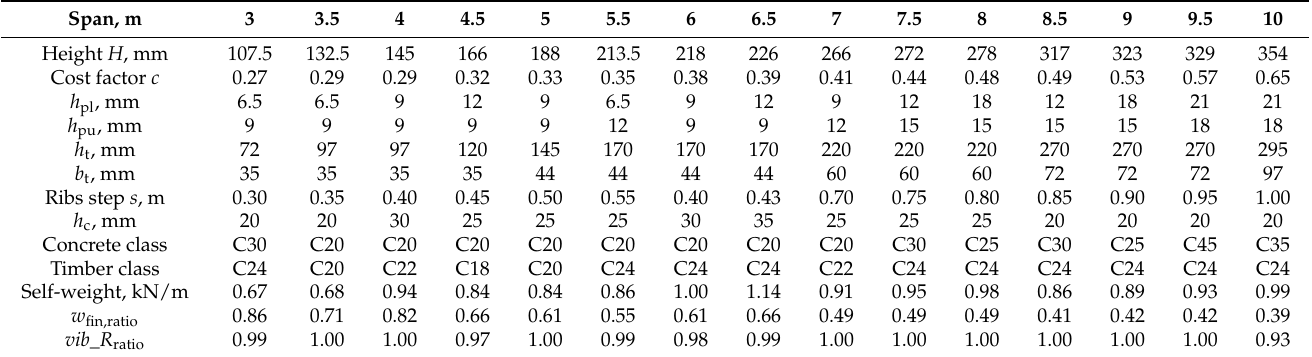
Table 8. The most rational cross-sectional parameters of the CLT–concrete composite panel for category